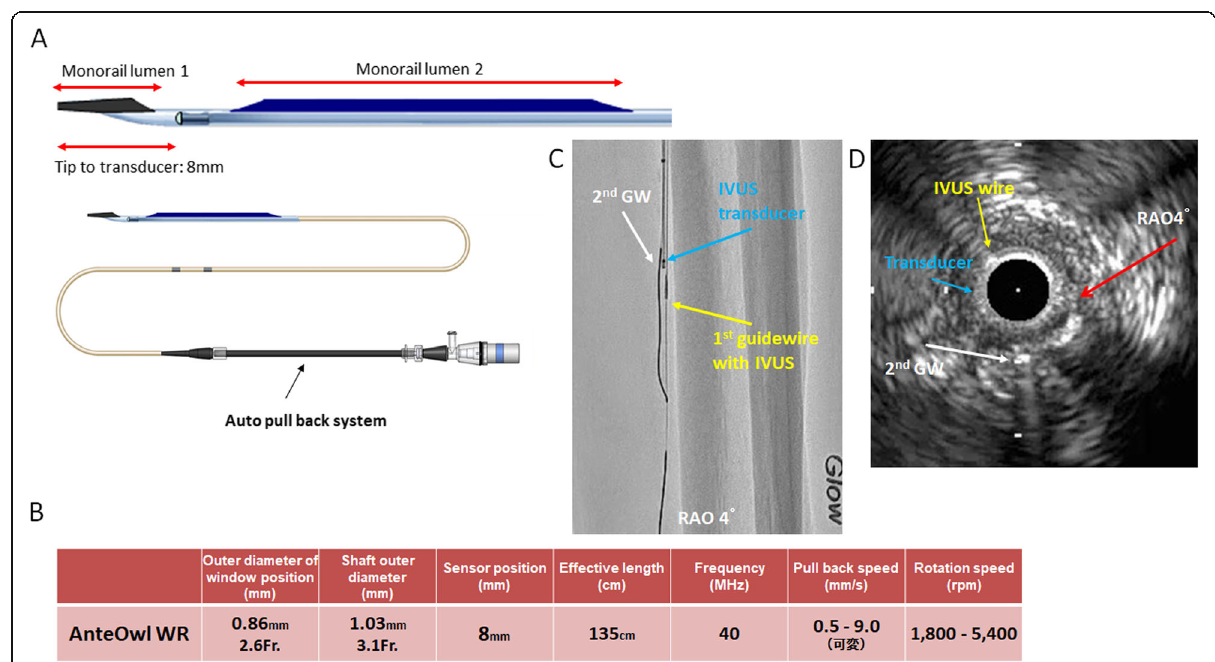
Fig. 1 A Structure of the AnteOwl WR (AnteOwl) intravascular ultrasound (IVUS). B Specifications of the AnteOwl. C Angiographic images of the AnteOwl in a below-the-knee lesion in the right anterior oblique (RAO) 4° view. The 1st guidewire (yellow arrow) and AnteOwl IVUS transducer (blue arrow) are in the posterior tibial artery. The 2nd guidewire (GW) is indicated by the white arrow on the left side of the IVUS (right anterior oblique side). D IVUS findings of the chronic total occlusion lesion. The detector direction where the transducer and target plaque are maximally separated is at RAO4° (red arrow). Blue arrow: IVUS transducer; yellow arrow: IVUS wire (1st guidewire); white arrow: 2nd GW successfully advanced into the target